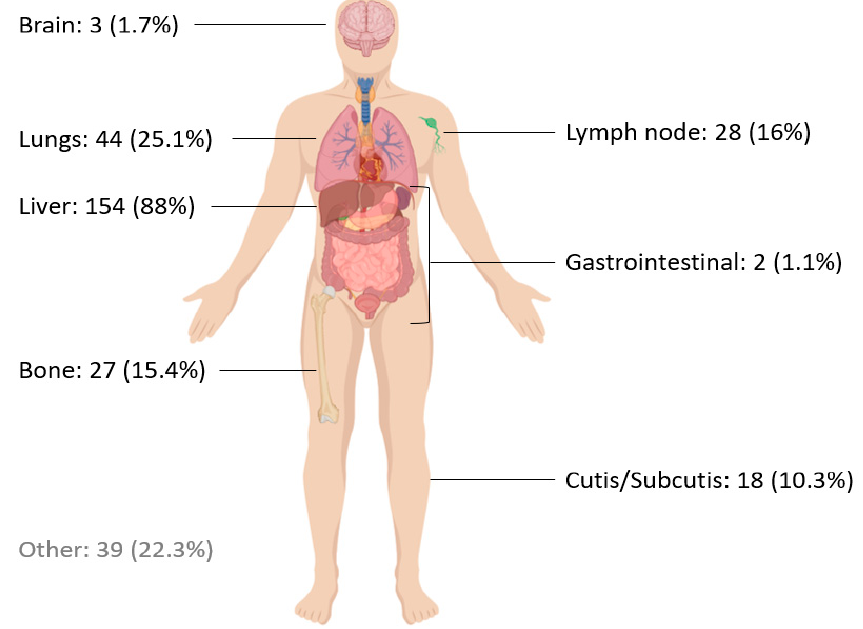
Figure 2. Frequency of affected organ in our cohort of patients with metastatic uveal melanoma. (More than one organ can be affected).